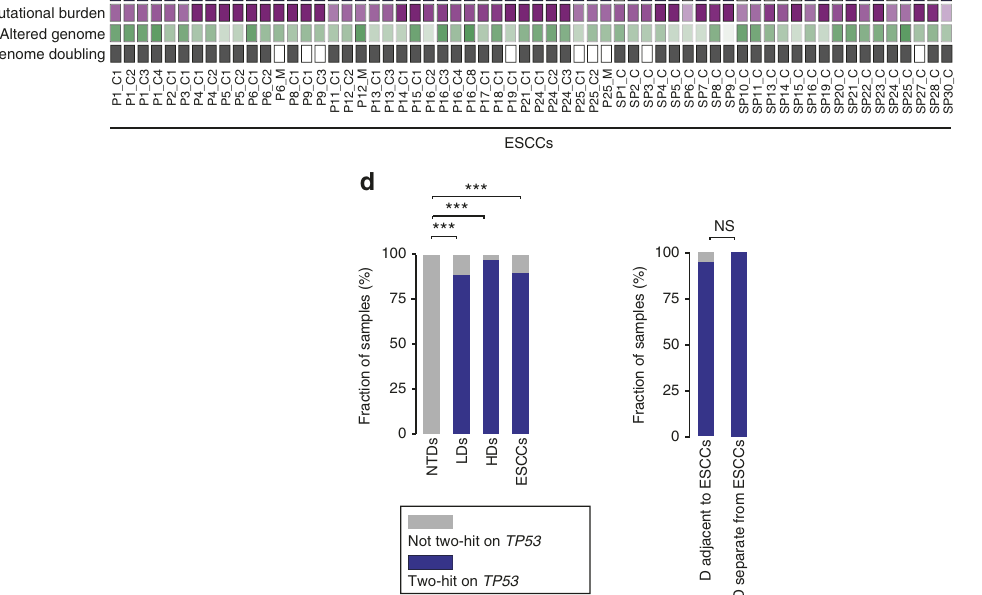
Fig. 6 Mutation and loss of heterozygosity analysis of TP53 . a Bar plots displaying the number of ‘ trunk ’ ( gray ) or ‘ branch ’ ( green ) mutations in indicated driver genes. The statistical signi fi cance is shown (Fisher ’ s exact test). b Schematics of protein changes in TP53 identi fi ed in dysplasia samples ( top ) and ESCCs ( bottom ). Altered loci with high frequency are indicated. c Diagrams showing the TP53 mutations, TP53 loss of heterozygosity (LOHs), mutational burden, fraction of genome affected by CNAs, and genome doubling status. Each column represents a sample (sample name labeled below). d Comparison of the number of samples with or without the ‘ two-hit ’ event on TP53 across three groups (NTDs, LDs, HDs, and ESCCs). Dysplasia samples adjacent to and separate from ESCCs in the TD cohort were also compared. Fisher ’ s exact test, *** P < 0.001, NS, not signi fi